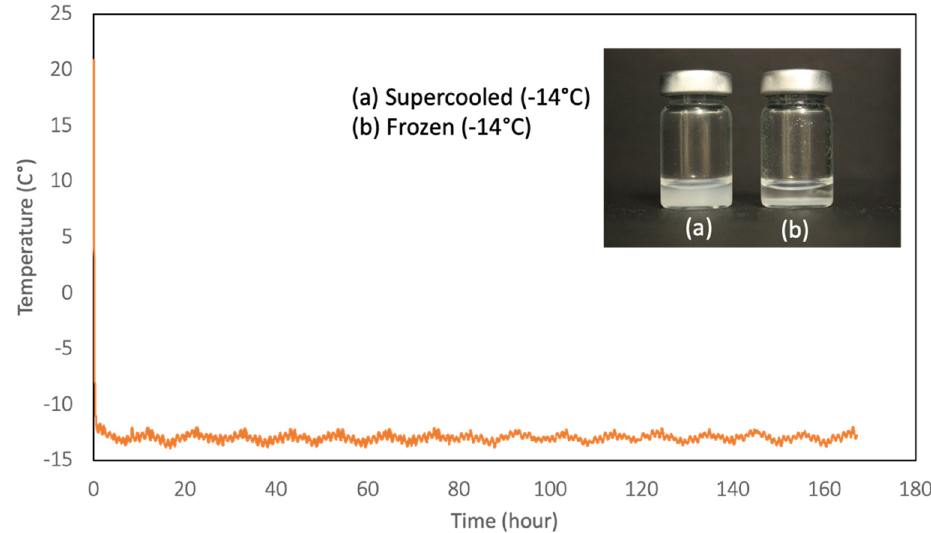
Figure 6. Temperature profiles of study vaccines after 7 days of storage: ( a ) supercooled ( − 14 ◦ C) and ( b ) frozen ( − 14 ◦ C). Inserts show snapshots of supercooled and control vaccines after shake tests.